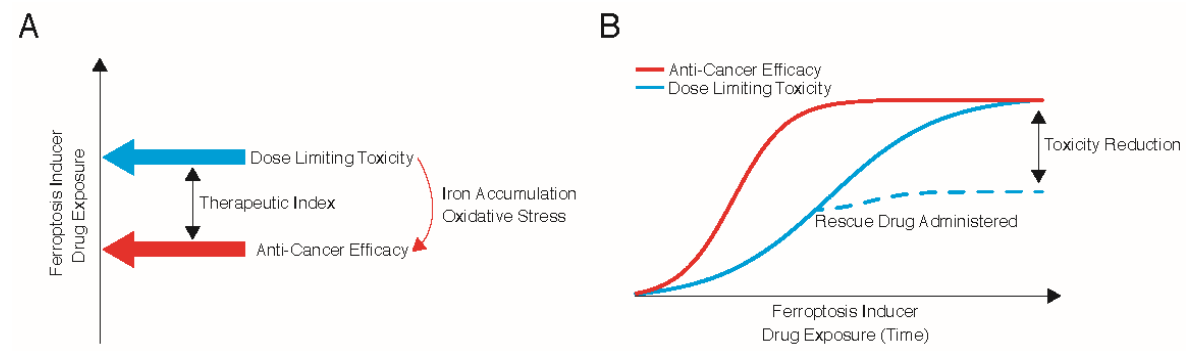
Figure 3. Therapeutic Index for Ferroptosis Inducers. ( A ) Schematic depiction of the proposed therapeutic index for ferroptosis inducers as anti-cancer agents. ( B ) The potential use of rescue drugs following ferroptosis inducer treatment. Rescue drugs could be administered once the maximal efficacy of ferroptosis inducers has been reached to reduce dose limiting toxicities without diminishing the effects on tumours.